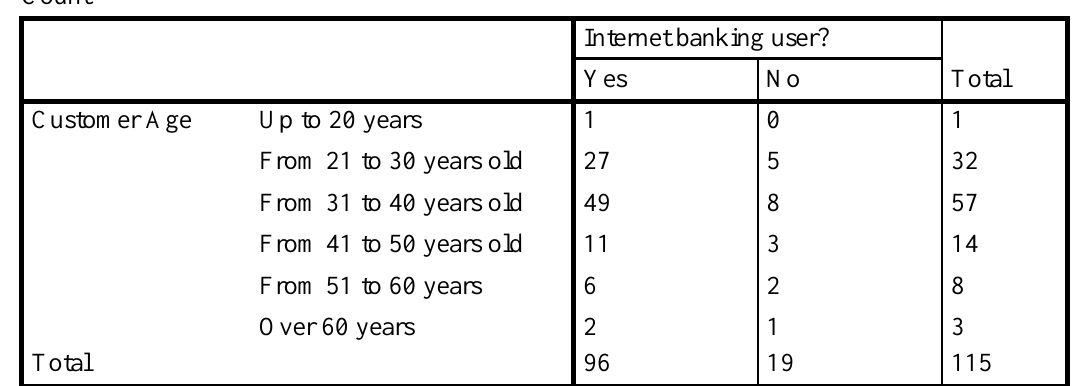
Table 5. Internet banking users vs. age group crosstabulation